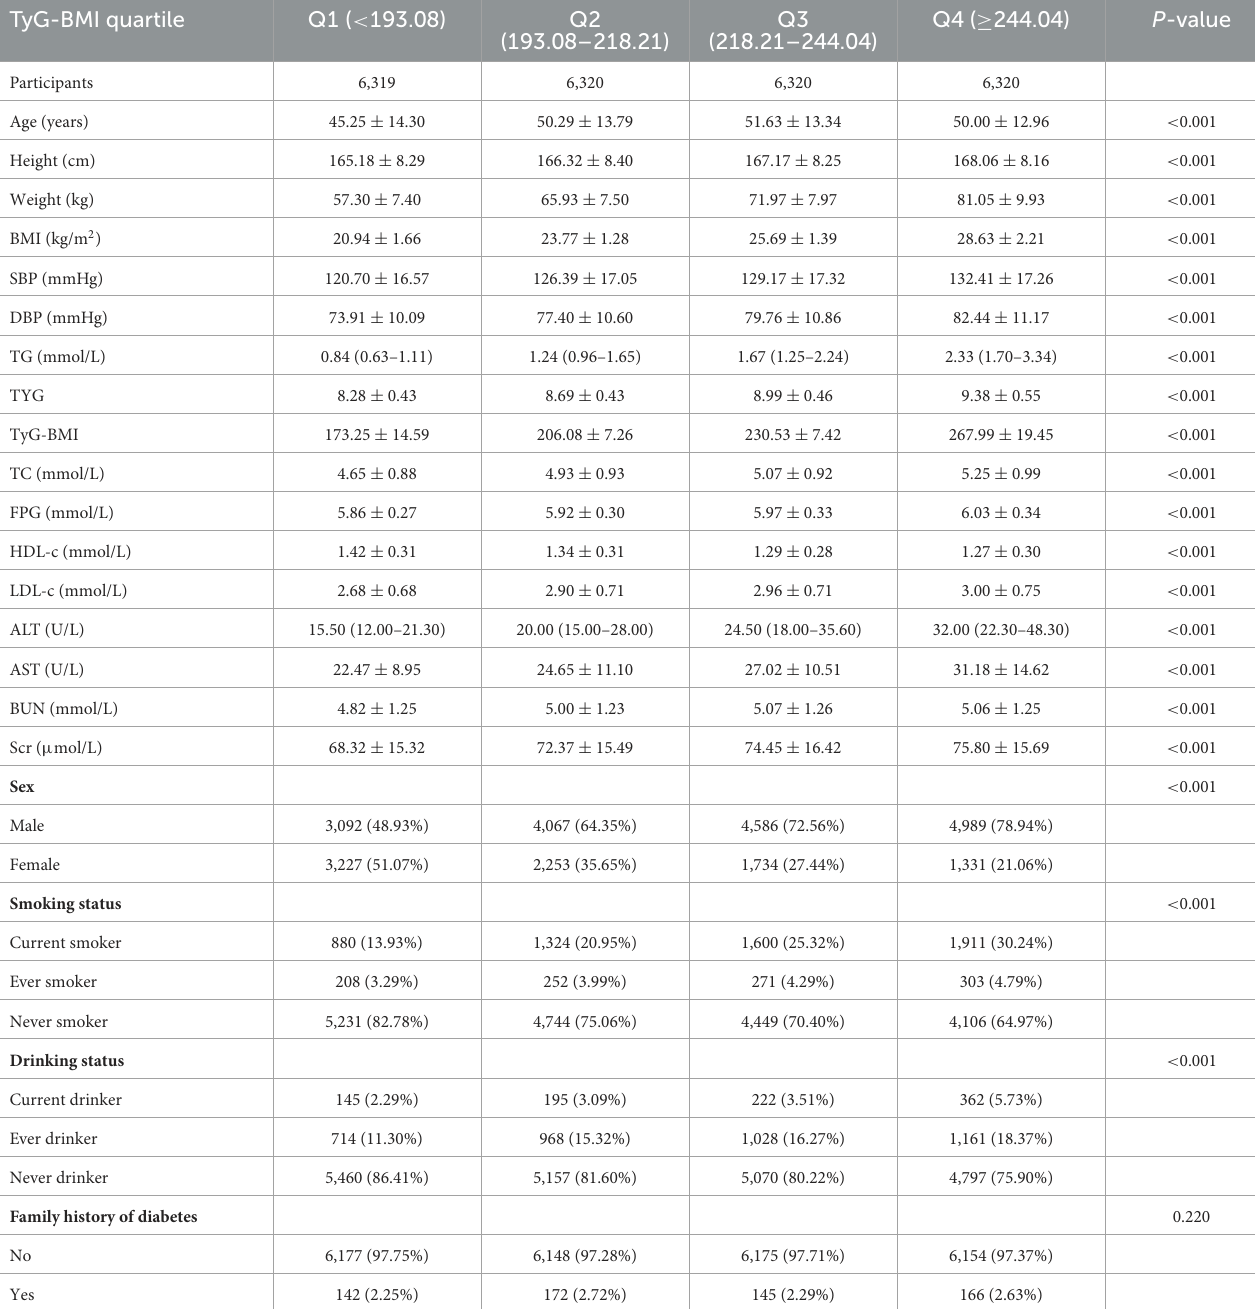
Continuousvariablesweresummarizedasmean(SD)ormedians(quartileinterval);categoricalvariablesweredisplayedaspercentage(%). FPG,fastingplasmaglucose;DBP,diastolicbloodpressure;BMI,bodymassindex;TC,totalcholesterol;TG,triglyceride;SBP,systolicbloodpressure;TyG,thetriglyceride-glucoseindex;TyG-BMI, triglycerideglucose-bodymassindex;AST,aspartateaminotransferase;ALT,alanineaminotransferase;LDL-C,low-densitylipidcholesterol;BUN,bloodureanitrogen;Scr,serumcreatinine.HDL-c, high-densitylipoproteincholesterol.